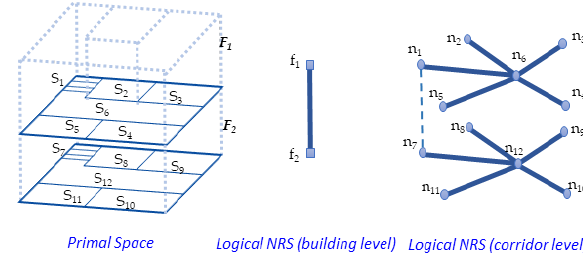
Figure 1 . Topological relationships in a node hierarchy in NRS IndoorGML’s network structure composed of nodes and edges represents the indoor spaces and their topological relationships, respectively. This standard’s theoretical background is based on the Node-Relation Structure (NRS), a logical data model which utilizes the Poincare Duality to convert primal space into dual space (Lee and Kwan, 2005). Notably, the NRS is described as a hierarchical model, where a higher-level node from the network can represent a sub-network composed of lower-level nodes. In